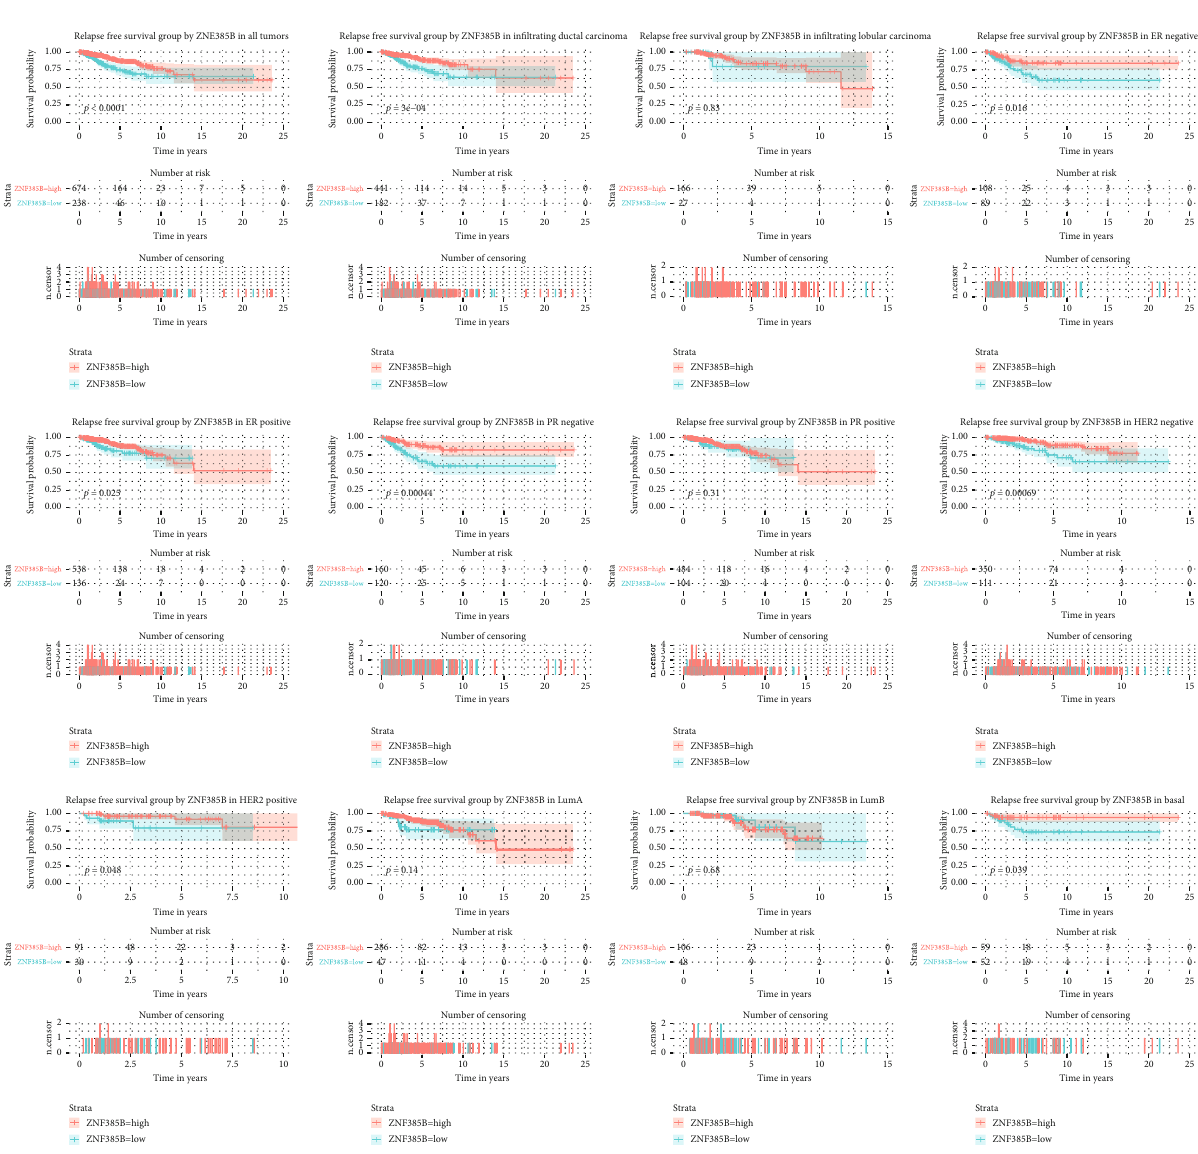
Figure 4: Kaplan-Meier curves of RFS in breast cancer. Kaplan-Meier curves for RFS in all tumors, di ff erent histological types (in fi ltrating ductal carcinoma and in fi ltrating lobular carcinoma), ER, PR, HER-2, and molecular subtype (LumA, LumB, and